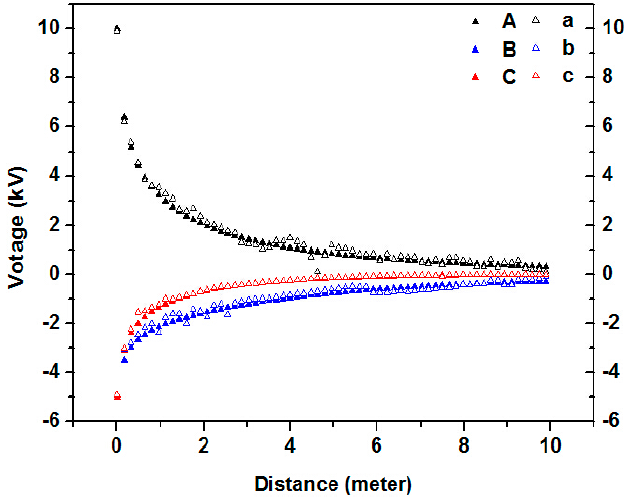
Figure 10. Comparison of simulation and measurement results.